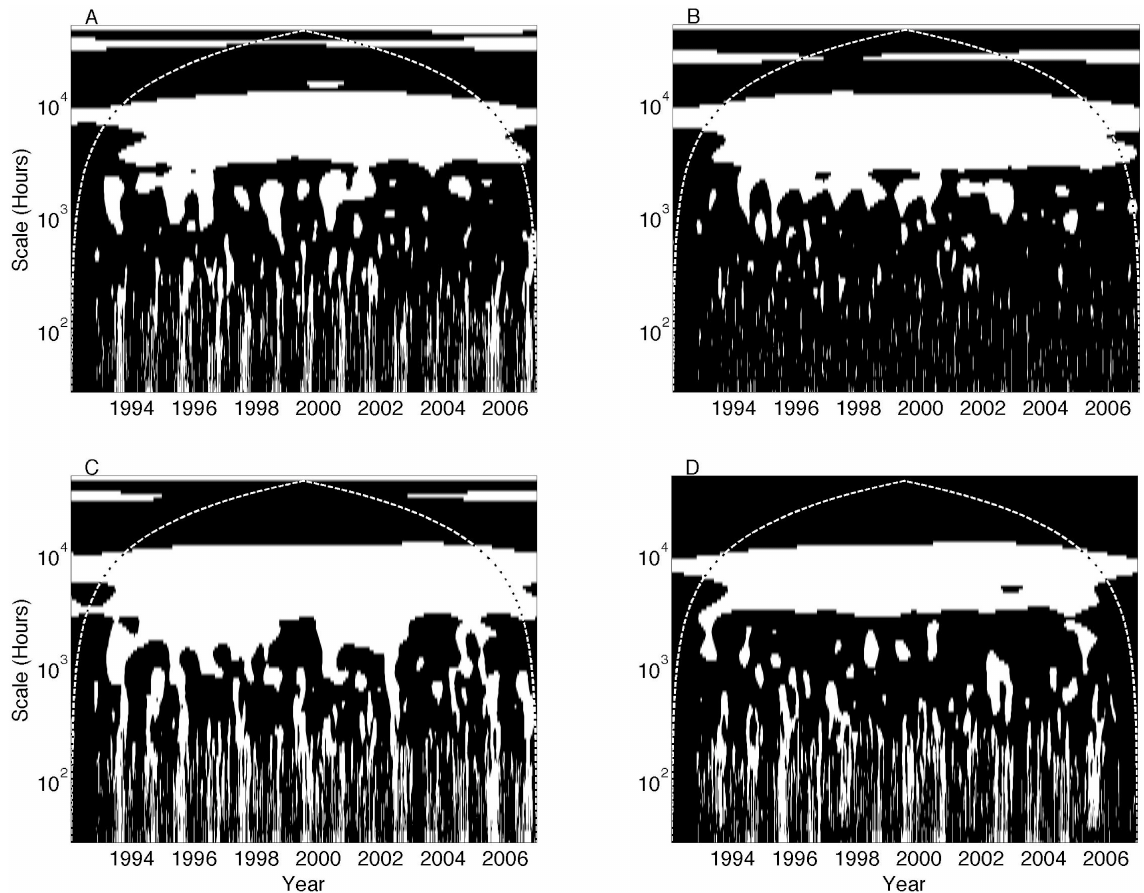
Fig. 3. Same as Fig. 2 but showing significant wavelet coherence at timescales greater than 2days between NEE measurements at Harvard Forest (US-Ha1) and the (A) SiBCASA, (B) ED2, (C) LoTEC and (D) ORCHIDEE model